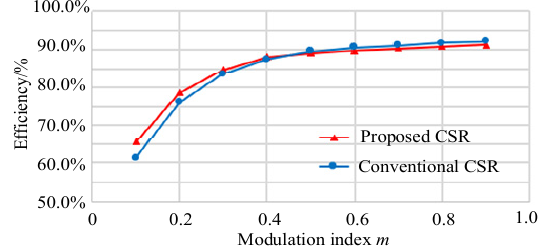
Figure 16. E ffi ciency comparison of di ff erent CSRs. Figure 16. Efficiency comparison of different CSRs. Figure 16. Efficiency comparison of different CSRs.